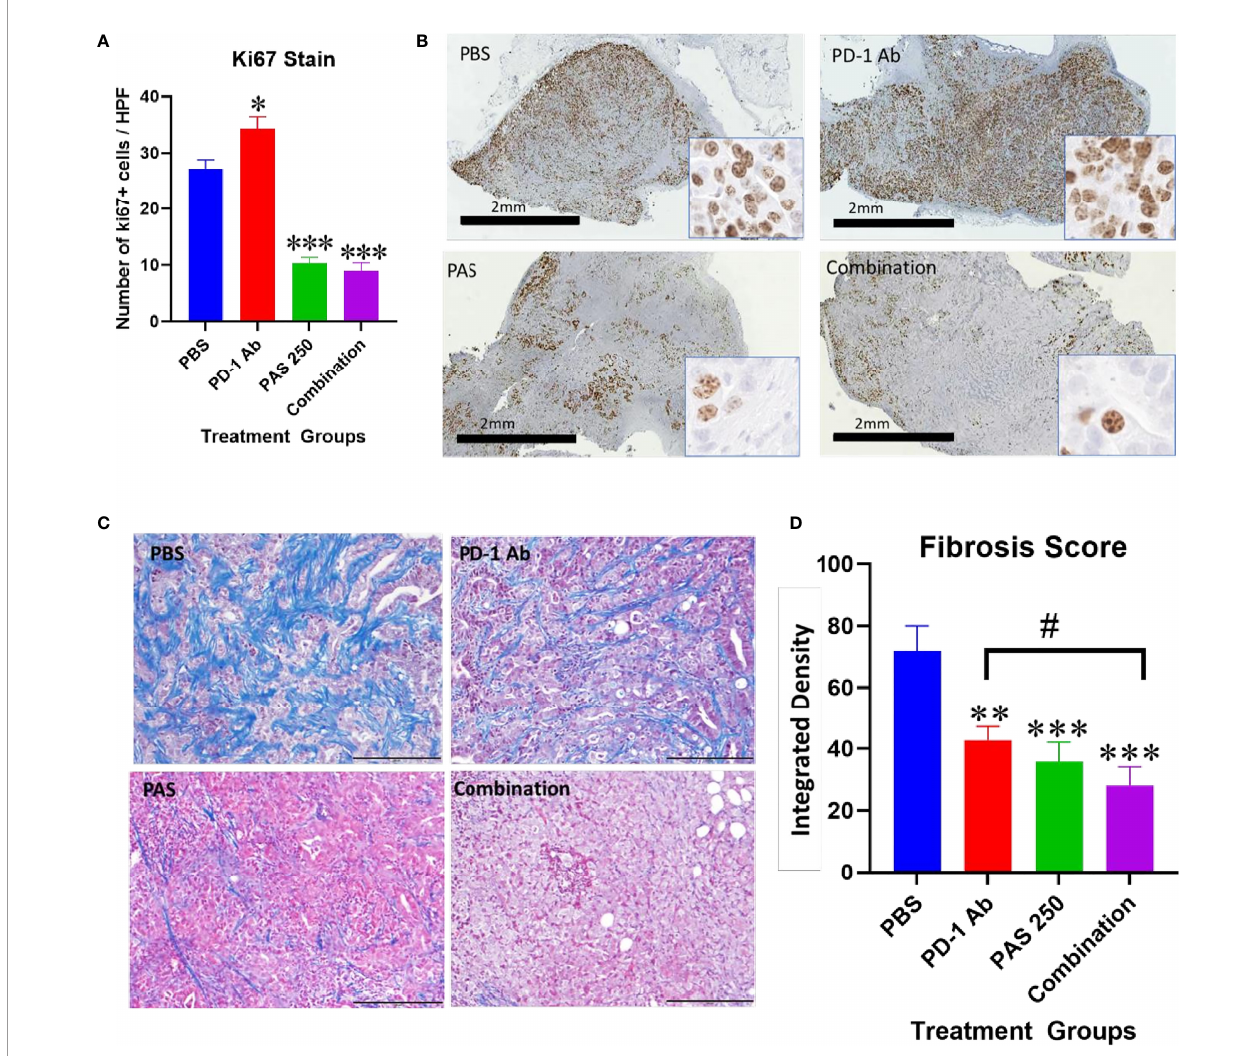
FIGURE 4 | Effects of PAS and PD-1 Ab treatment on tumor proliferation and fi brosis. (A) The mean number ± SEM of Ki67 stained cells is shown for each cohort of YTN tumors. Ki67 immunoreactivity in PD-1 Ab tumors increased compared to PBS-treated controls (P <0.05). * Signi fi cantly different from control. Ki67 staining was signi fi cantly reduced in tumors of mice treated with PAS monotherapy or in combination with the PD-1 Ab (P <0.0001). (B) Representative images from tumors reacted with Ki67 antibody for each treatment group is show at low magni fi cation (2×, bar scale, 2 mm) and at a higher magni fi cation (40×, Box insert). (C) Representative images of tumors from each treatment group stained for fi brosis with Masson ’ s trichrome stain (scale bar = 200 m m). (D) Mean values ± SEM for fi brosis staining is shown for each treatment as analyzed by integrated density. Intratumoral fi brosis was decreased in all treatment groups compared to PBS-treated control tumors. Tumors of the combination therapy group also exhibited less fi brosis than tumors of the mice treated with PD-1 Ab monotherapy. (Compared to PBS **P < 0.01; ***P < 0.001; compared to PD-1 Ab #